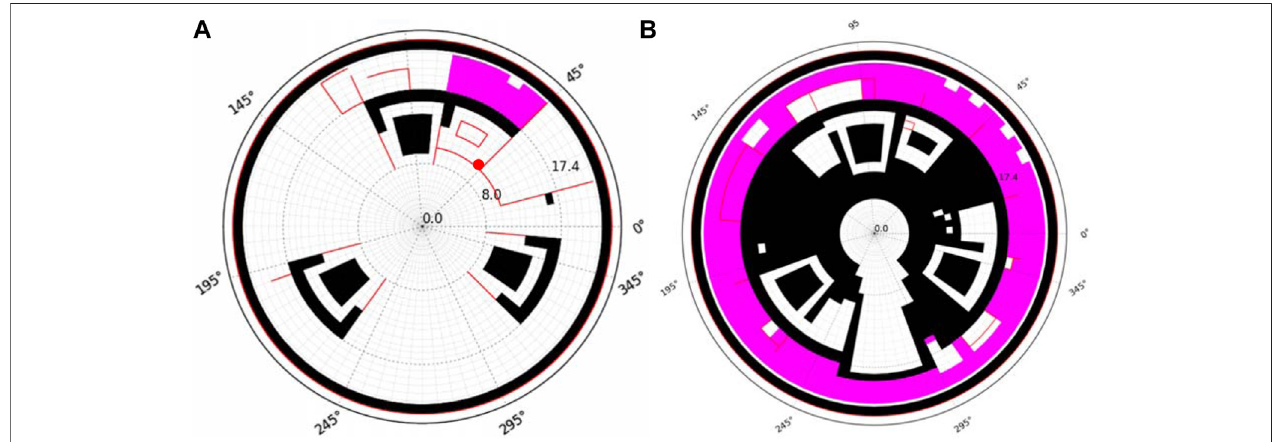
FIGURE 6 | Cross-section view of the containment geometry model-case0. (A) Cross-section at the height of the injection (red point: igniting point). (B) Cross- section at the 17.5 m.